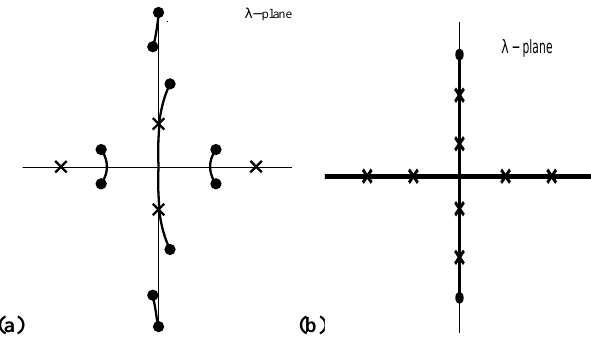
Fig. 1. Spectrum of (a) a generic unstable N-phase solution and (b) the plane wave solution. The simple periodic eigenvalues are labeled by circles and the double points by crosses.